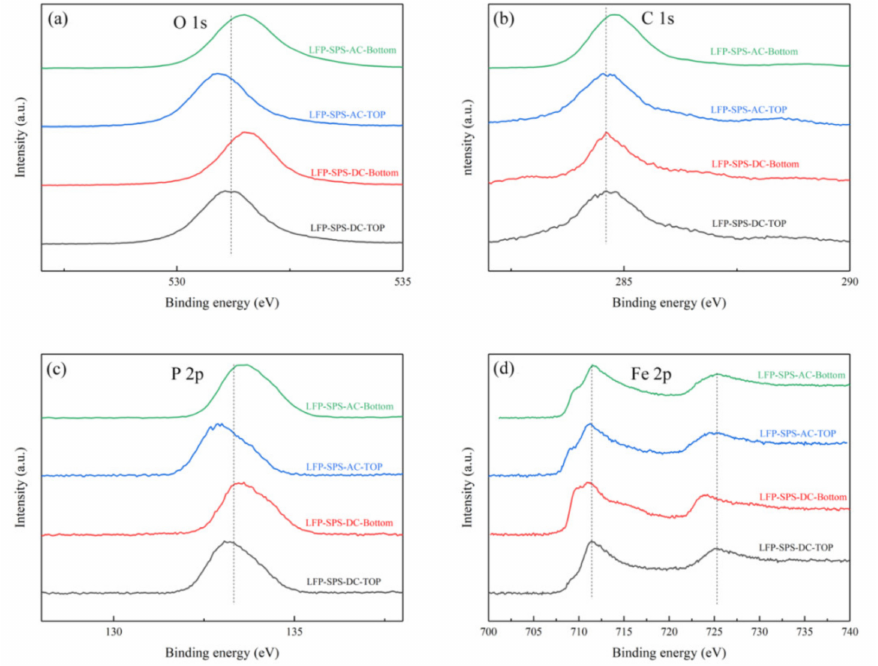
Figure 4. The high-resolution XPS spectra of ( a ) C 1s, ( b ) O 1s, ( c ) P 2p, and ( d ) Fe 2p in different